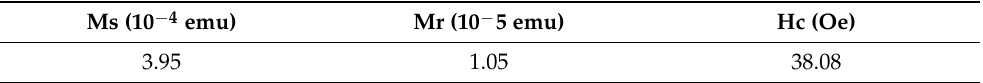
Figure 8. M–H loops of NiO sprayed thin film. Table 5. Values of Coercivity (Hc), Magnetization (Ms), and Retentivity (Mr) of NiO thin